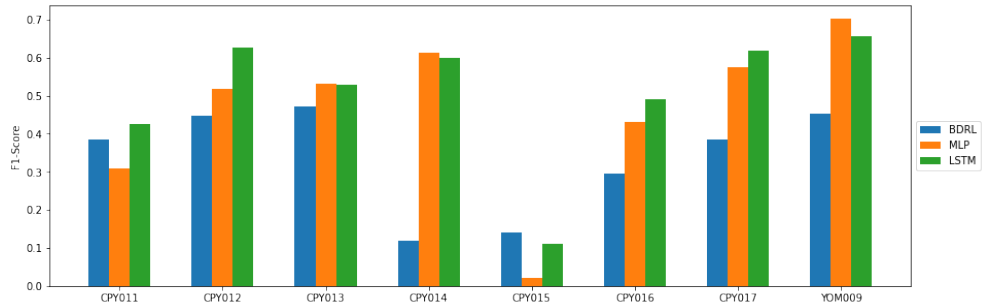
Figure 7. Bar charts of average F1-scores of the DRL, MLP, and LSTM when tested with the data collected from different